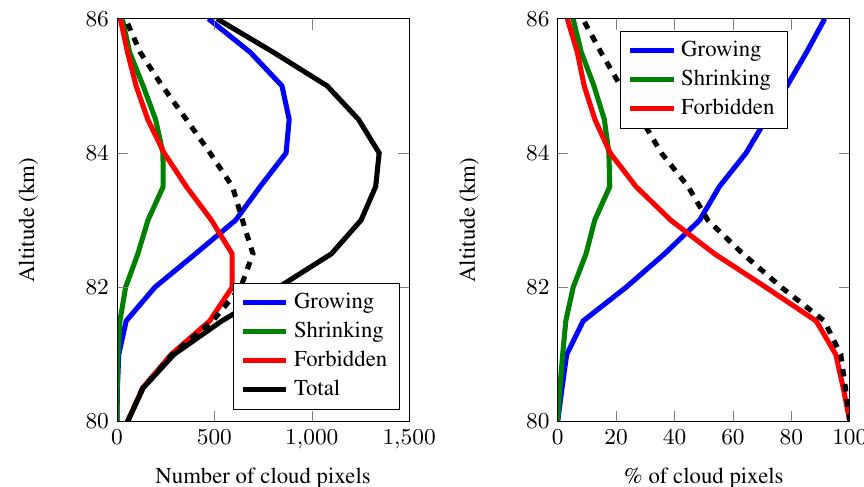
Figure 4. Classification of clouds measured by OSIRIS. The left plot shows the number of pixels measured of each type, while the right plot shows the percentage of cloud pixels in each phase. The blue lines show clouds in a growing phase, the green lines indicate that the clouds are sublimating, but that cloud presence is expected in equilibrium, and the red lines show clouds not expected in thermodynamic equilibrium. The black solid line are the total number of clouds detected, while the black dashed lines show the total number of sublimating clouds (i.e. red and